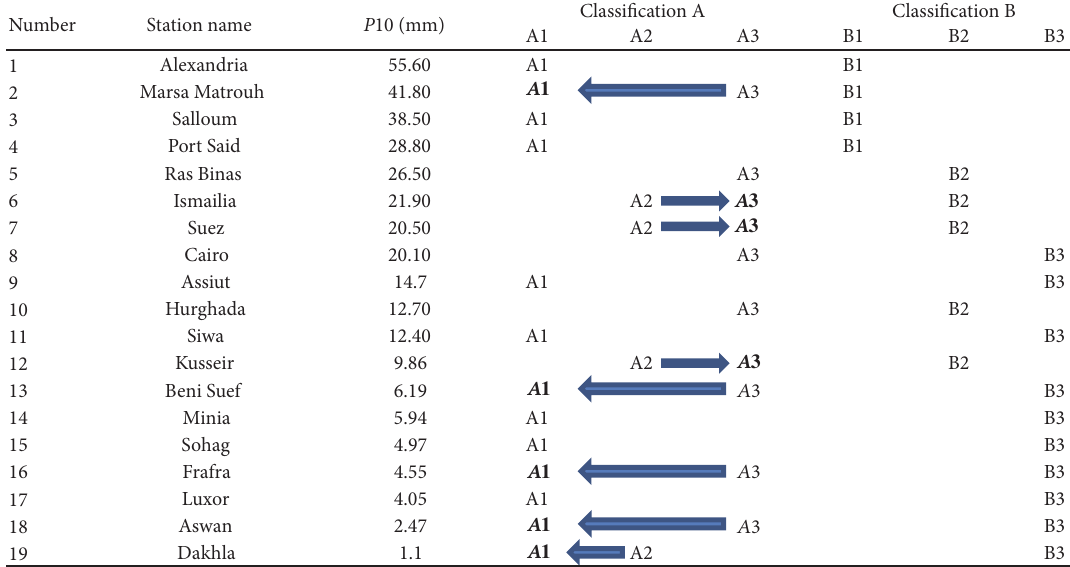
Figure 3: Modifications on station